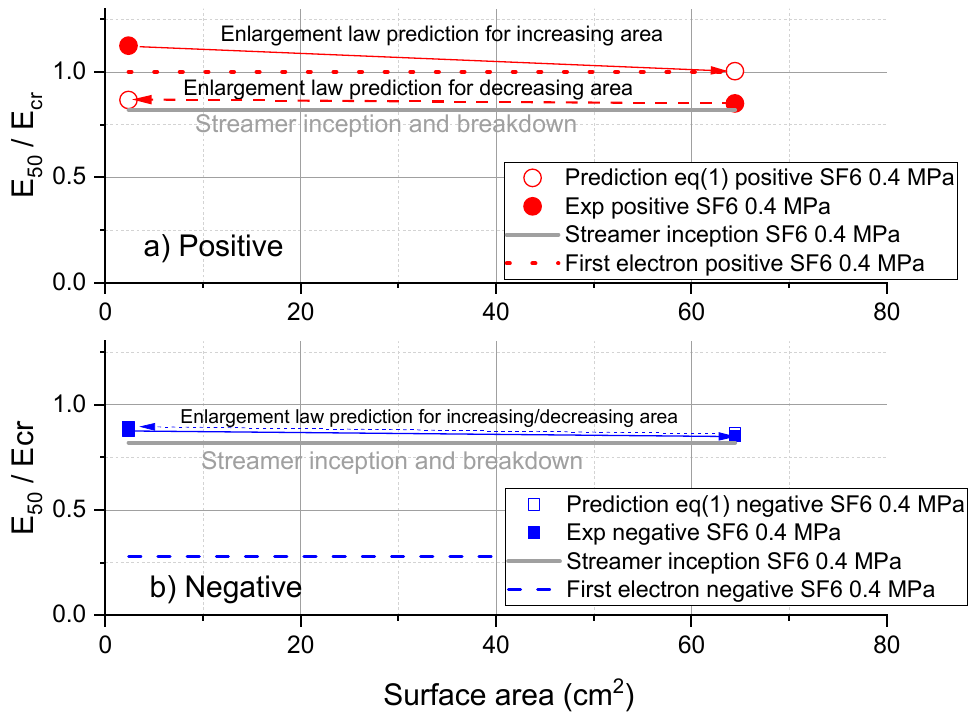
Figure 14. Normalized breakdown fields E 50 / E cr vs. effective surface area in SF 6 at 0.4 MPa at ( a ) positive and ( b ) negative polarities. Calculations for first electron, streamer inception and breakdown at a single hemispherical protrusion of 20 μ m height are shown for comparison.